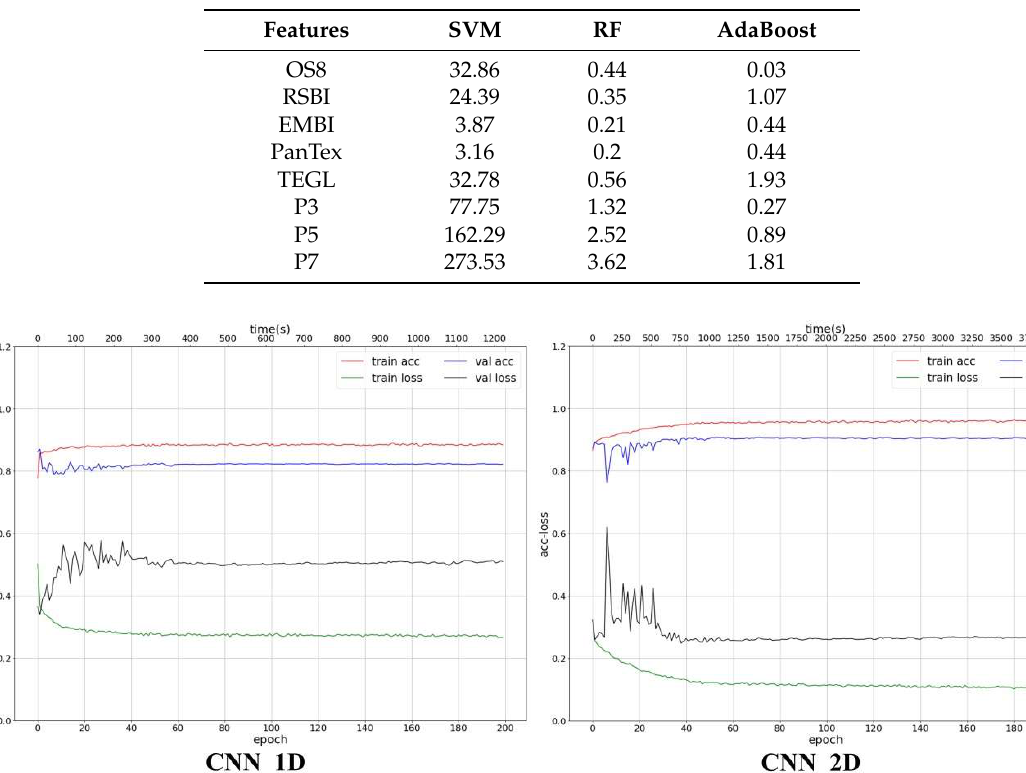
Table 7. The training time of the different classifier based on feature learning (unit: s).